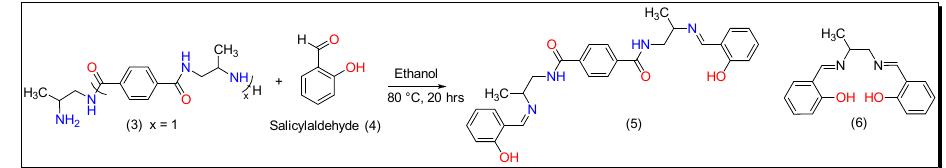
Figure 3. Chemical conversion of aminolysed product ( 3 ) to a Schiff base ( 5 ).